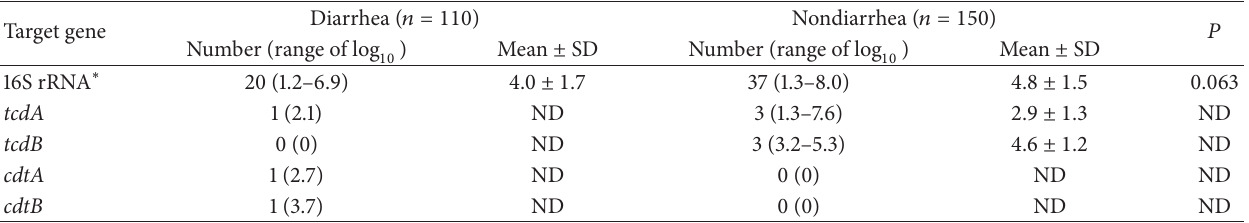
Table 2: Quantitative detection of Clostridium difficile and target genes in diarrhea and nondiarrhea samples. Target